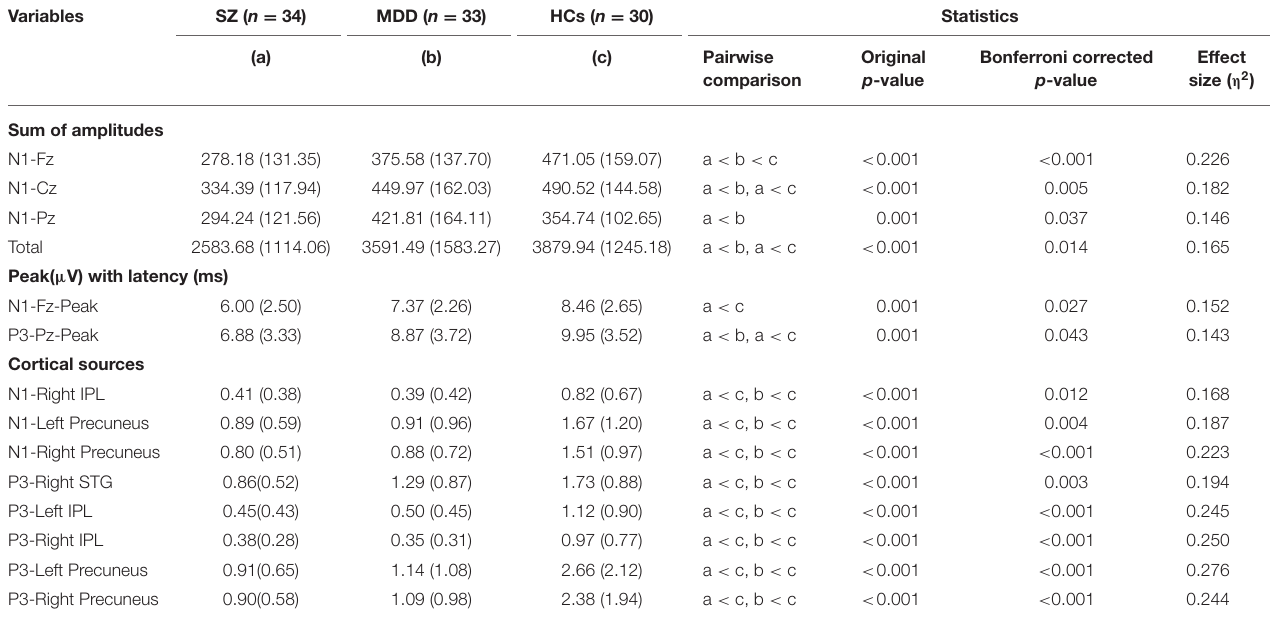
TABLE 2 | Comparisons of AP300 between patients and